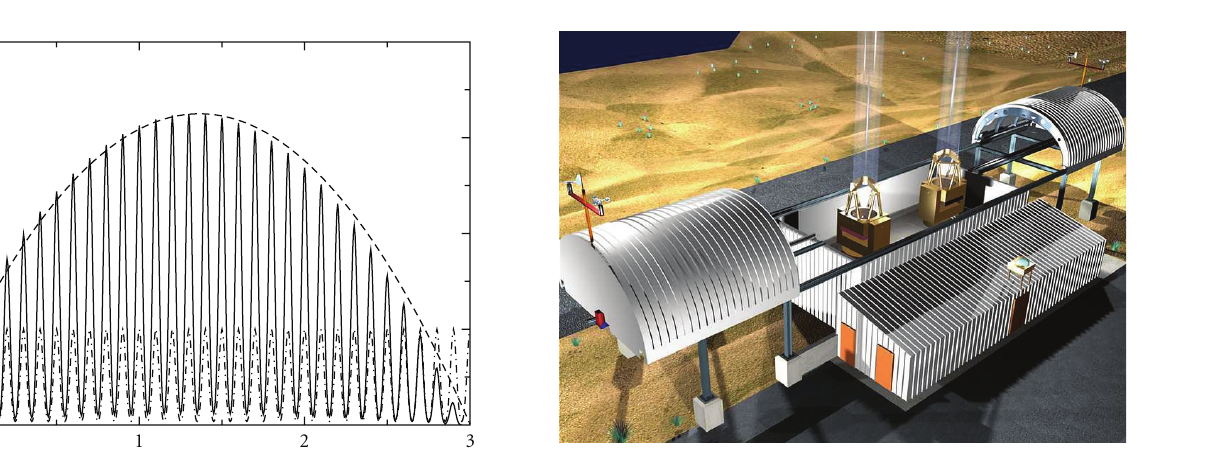
Figure 2: The layout of the STELLA building with the two roll- o ff roof halves. The building can be closed independently of the telescopes’ positions. This allows for faster closing times, and, even more importantly, it allows for shutdown also in case of telescope movement